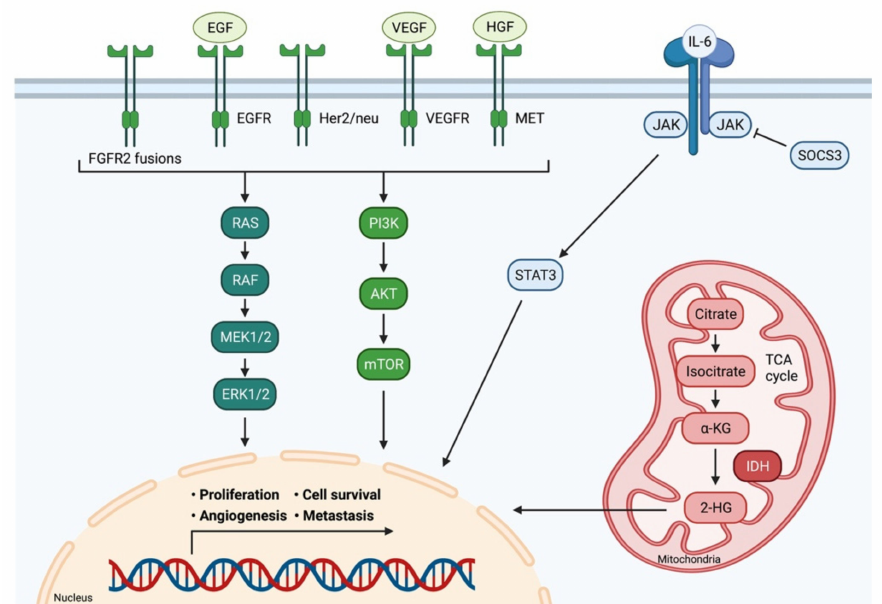
Figure 2. Signaling pathways in cholangiocarcinoma. Multiple signaling pathways are involved in the development and progression of CCA. Receptor tyrosine kinases activate the RAS-MAPK path- way and the PI3K-AKT pathway. IL-6 induces the JAK/STAT signaling pathway. Consequently, these pathways impact important cellular processes, such as cell proliferation, differentiation, survival, and angiogenesis. IDH 1/2 mutations lead to the accumulation of the oncometabolite intracellular 2-hydroxyglutarate (2-HG). Adapted from [30]. FGFR2: Fibroblast growth factor receptor 2; EGF: Epi- dermal growth factor; EGFR: Epidermal growth factor receptor; Her2/neu: Human epidermal growth factor receptor 2; VEGF: Vascular endothelial growth factor; VEGFR: Vascular endothelial growth factor receptor; HGF: Hepatocyte growth factor; MET: C-met-encoded receptor for hepatocyte growth factor; IL-6: Interleukin-6; JAK: Janus kinase; SOCS3: Suppressor of cytokine signaling 3; STAT3: Signal transducer and activator of transcription protein; RAS: Rat sarcoma; RAF: Rat fibrosarcoma; MEK1/2: Mitogen-activated protein kinase kinase; ERK1/2: Extracellular signal-regulated kinase 1/2; PI3K: Phosphatidylinositol 3 kinase; AKT: Protein kinase B; mTOR: Mammalian target of rapamycin; α -KG: α -Ketoglutaric acid; 2-HG: 2- hydroxyglutarate; IDH: Isocitrate dehydrogenase; TCA cycle: Citric acid